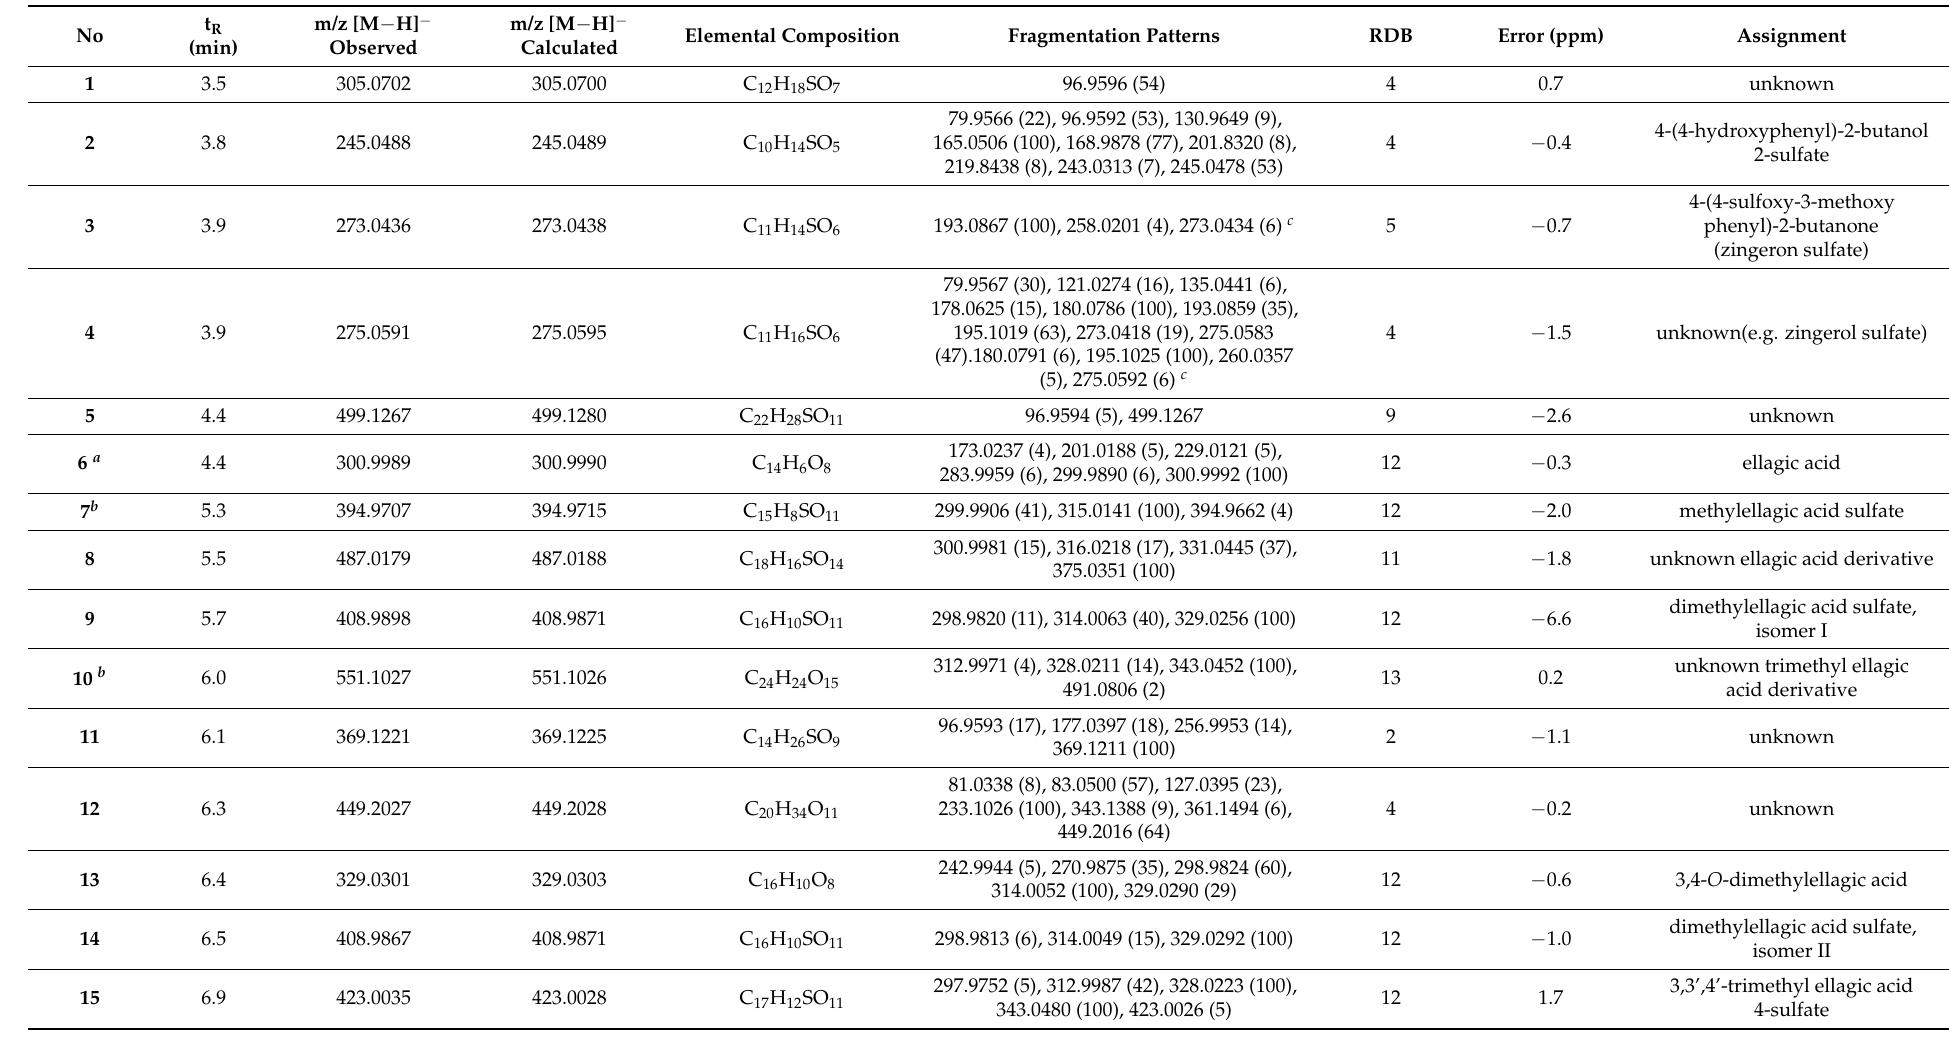
Table 2. Metabolites annotated in roots of Lumnitzera littorea and L. racemosa by reversed phase ultra-high-performance chromatography-tandem mass spectrometry (RP-UHPLC-MS/MS). The annotated metabolites are numbered according to peak numbers in Figure 2. Individual tandem mass spectra are shown in Figure